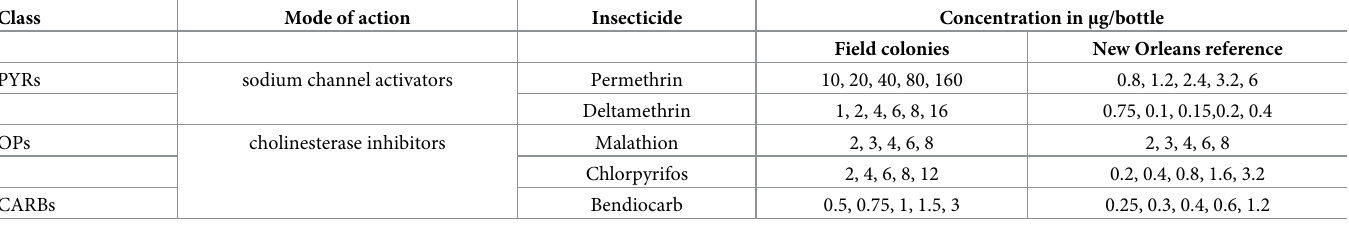
Table 2. Concentrations ( μ g/bottle) used to determine the LC 50 of five different insecticides in the bottle bioassay for field Aedes aegypti and the susceptible refer- ence